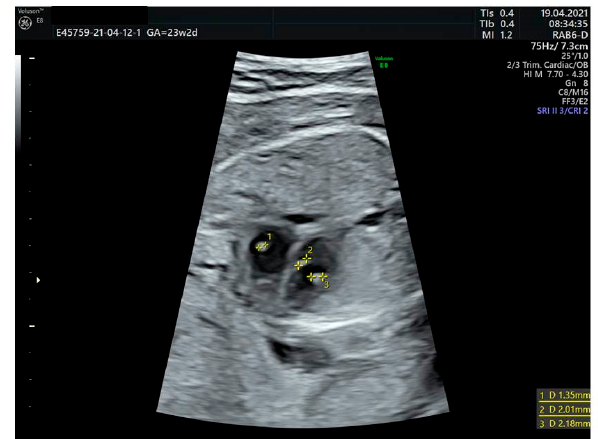
Figure 1. Multiple intracardiac hyperechogenic foci.